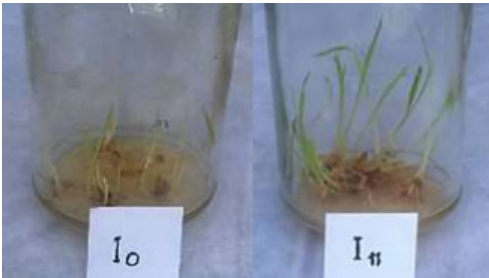
Fig. 3. The comparisan of rice seedlings growth in control (I-0) (left) and in isolate 11 (right)